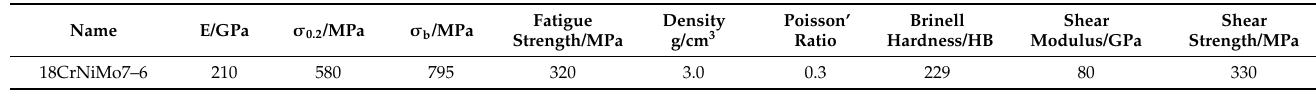
Table 3. Main mechanical property parameters of special alloy steel material at room temperature.